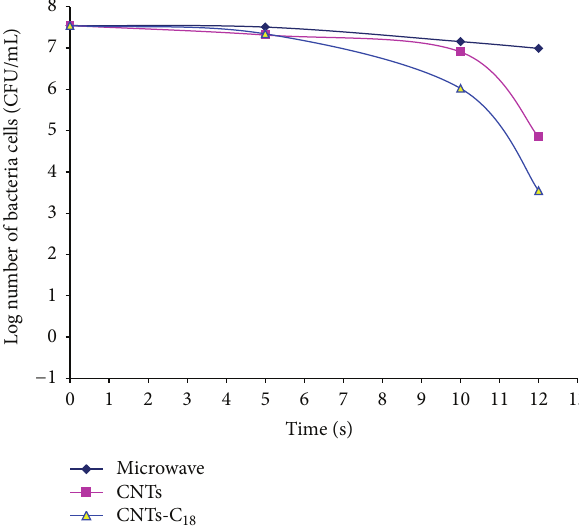
Figure 9: Effect of CNTs and functionalised CNTs-C 18 with and without microwave radiation on removal of bacteria from drinking